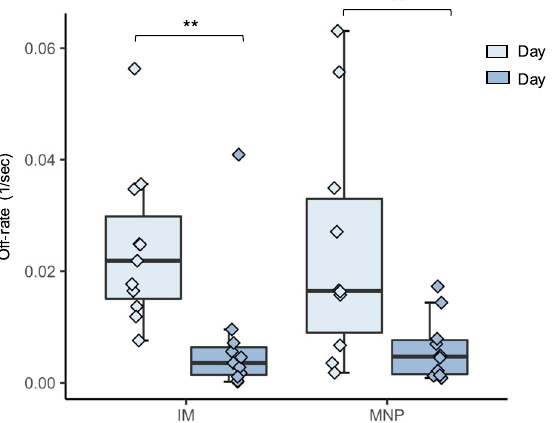
Fig. 3 Changes in antibody binding af fi nity at Day 28 post vaccination by vaccine delivery group (MNP: n = 10; IM: n = 11). SPR analysis of human plasma from various vaccine cohorts was performed with functional rHA1. Plasma antibody off-rate constants were determined as described previously in “ Methods ” . The box portion of the plot represents the interquartile range (IQR: 25th percentile, median, and 75th percentile) of the data. Error bars represent smallest and largest values within 1.5 times IQR. Black lines indicate statistical signi fi cance based on Wilcoxon rank-sum test. * P < 0.05; ** P < 0.01. IM, IIV by intramuscular route; MNP, IIV by microneedle patch.